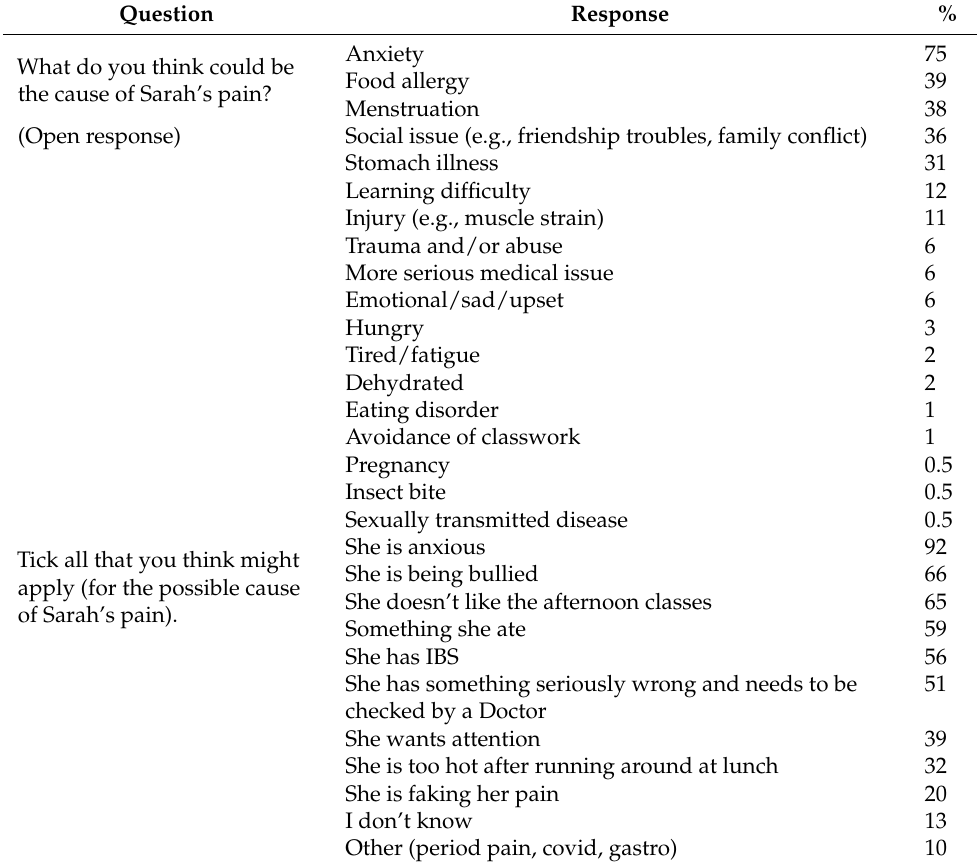
Table 2. Summary of responses about the possible cause of Sarah’s